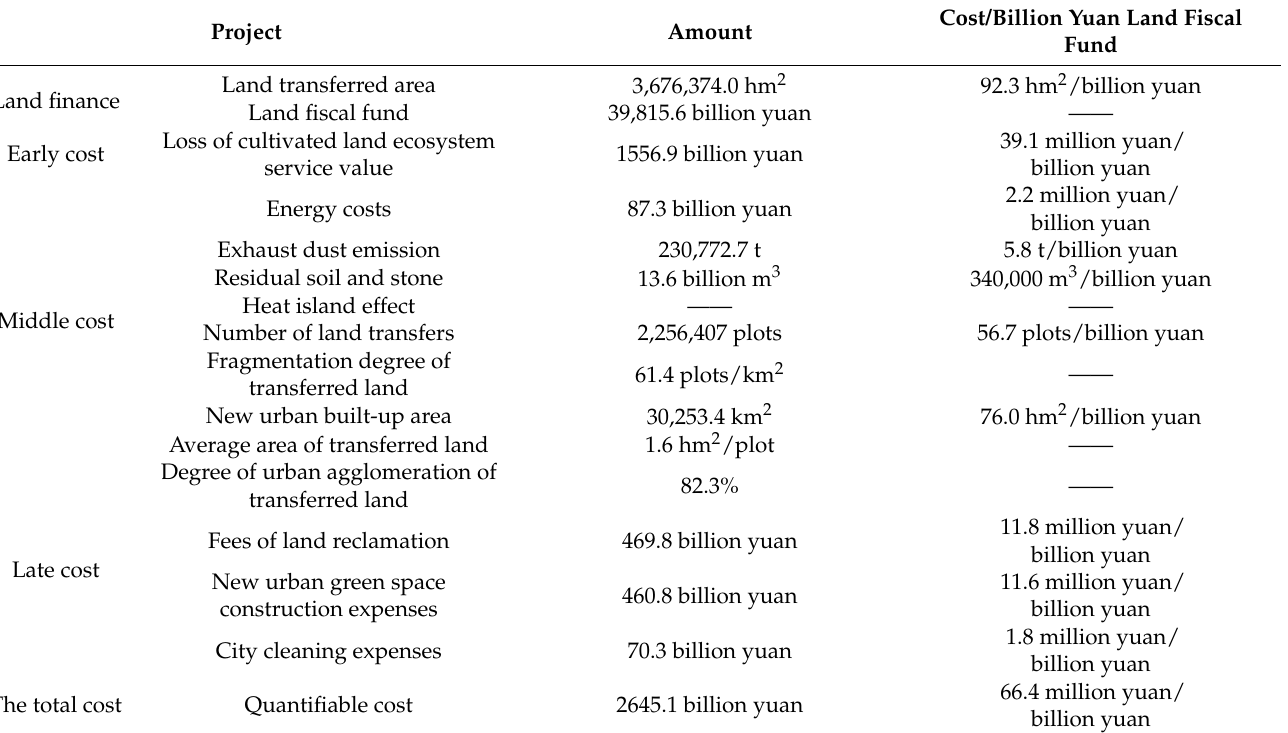
Table 5. Comprehensive scale of fiscal ecological costs of land in China from 2003 to